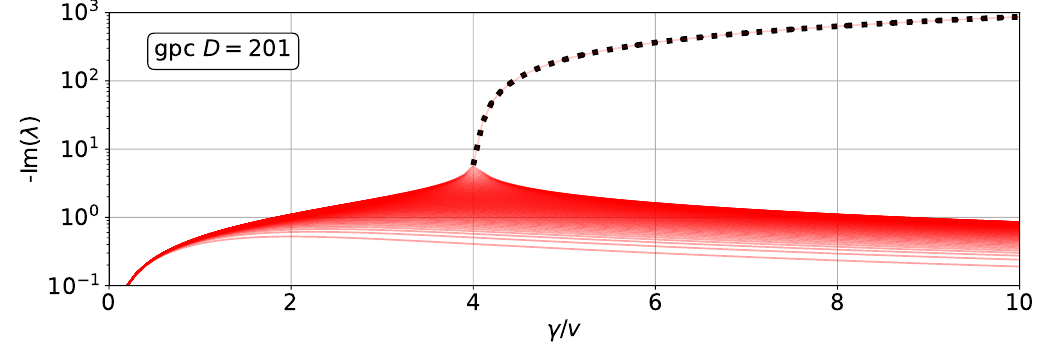
Figure 6: Eigenvalues of the ordered dissipative scattering model, see (68), calcu- lated with the gpc-generator and dimension D = 201, i.e. for N = 100. The eigenval- ues are represented by transparent lines, and the eigenvalue of the strongly dissipa- tive state starting at γ/ v = 4 is additionally marked by a dotted black